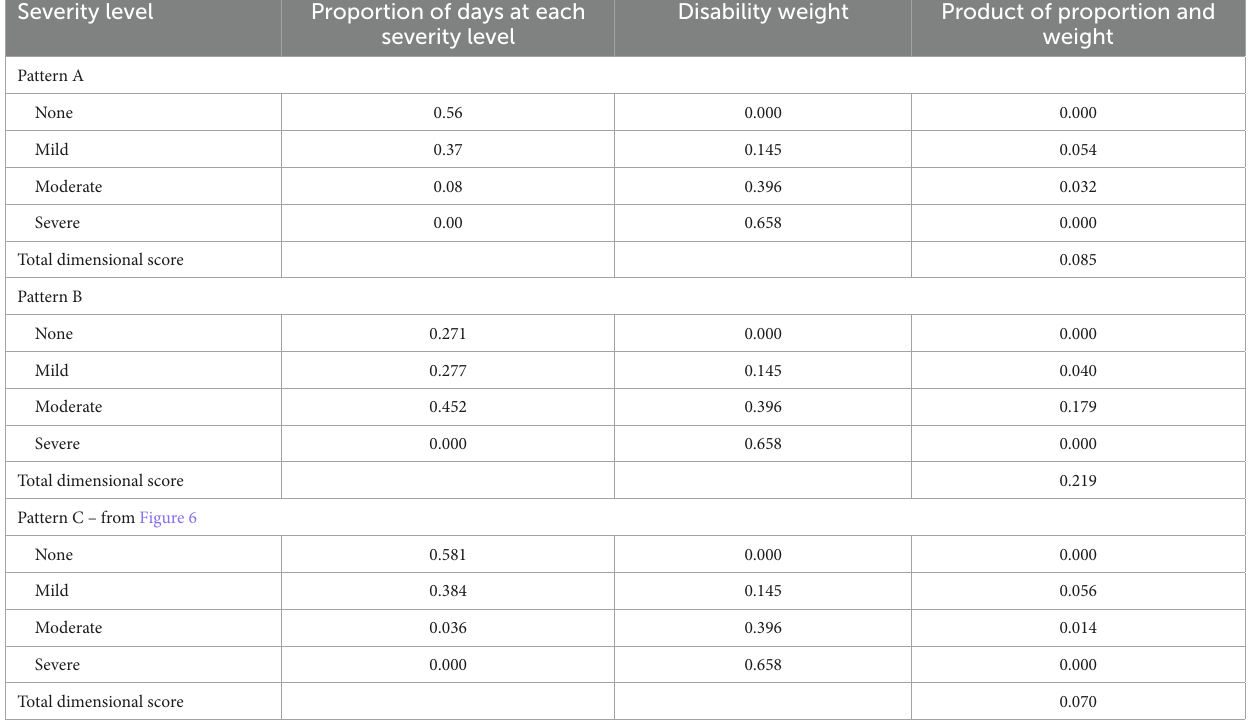
TABLE 1 Illustrative example of using health states and disability weights to construct a dimensional depression metric, data from Figures 4, 6. Severity level